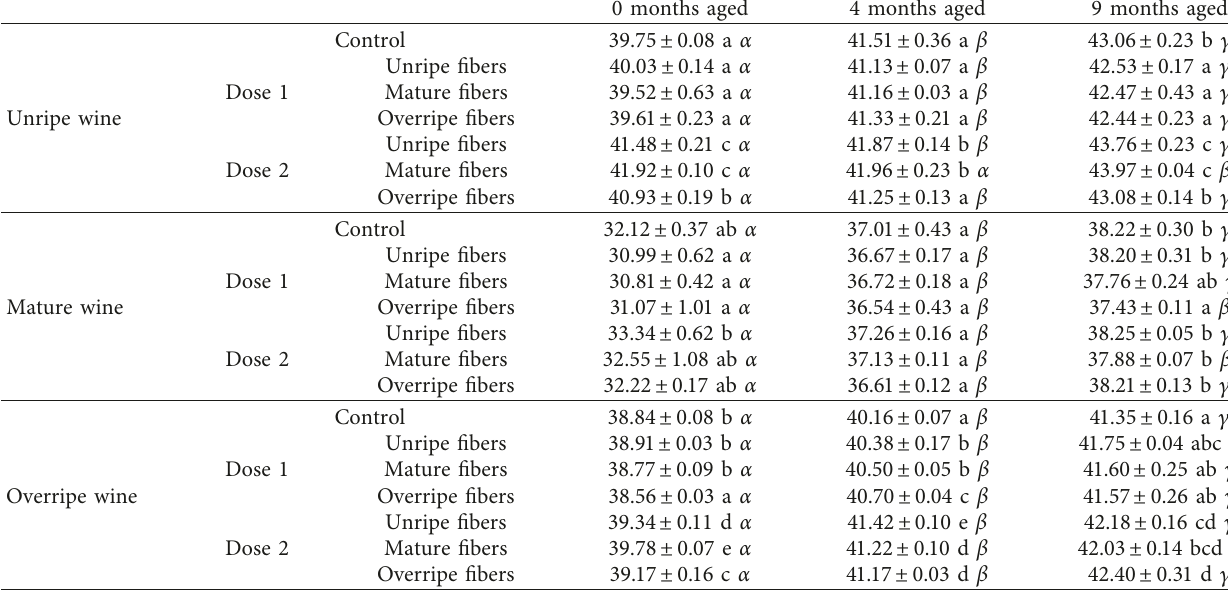
Table 7: Redness ( a ∗ ) of the